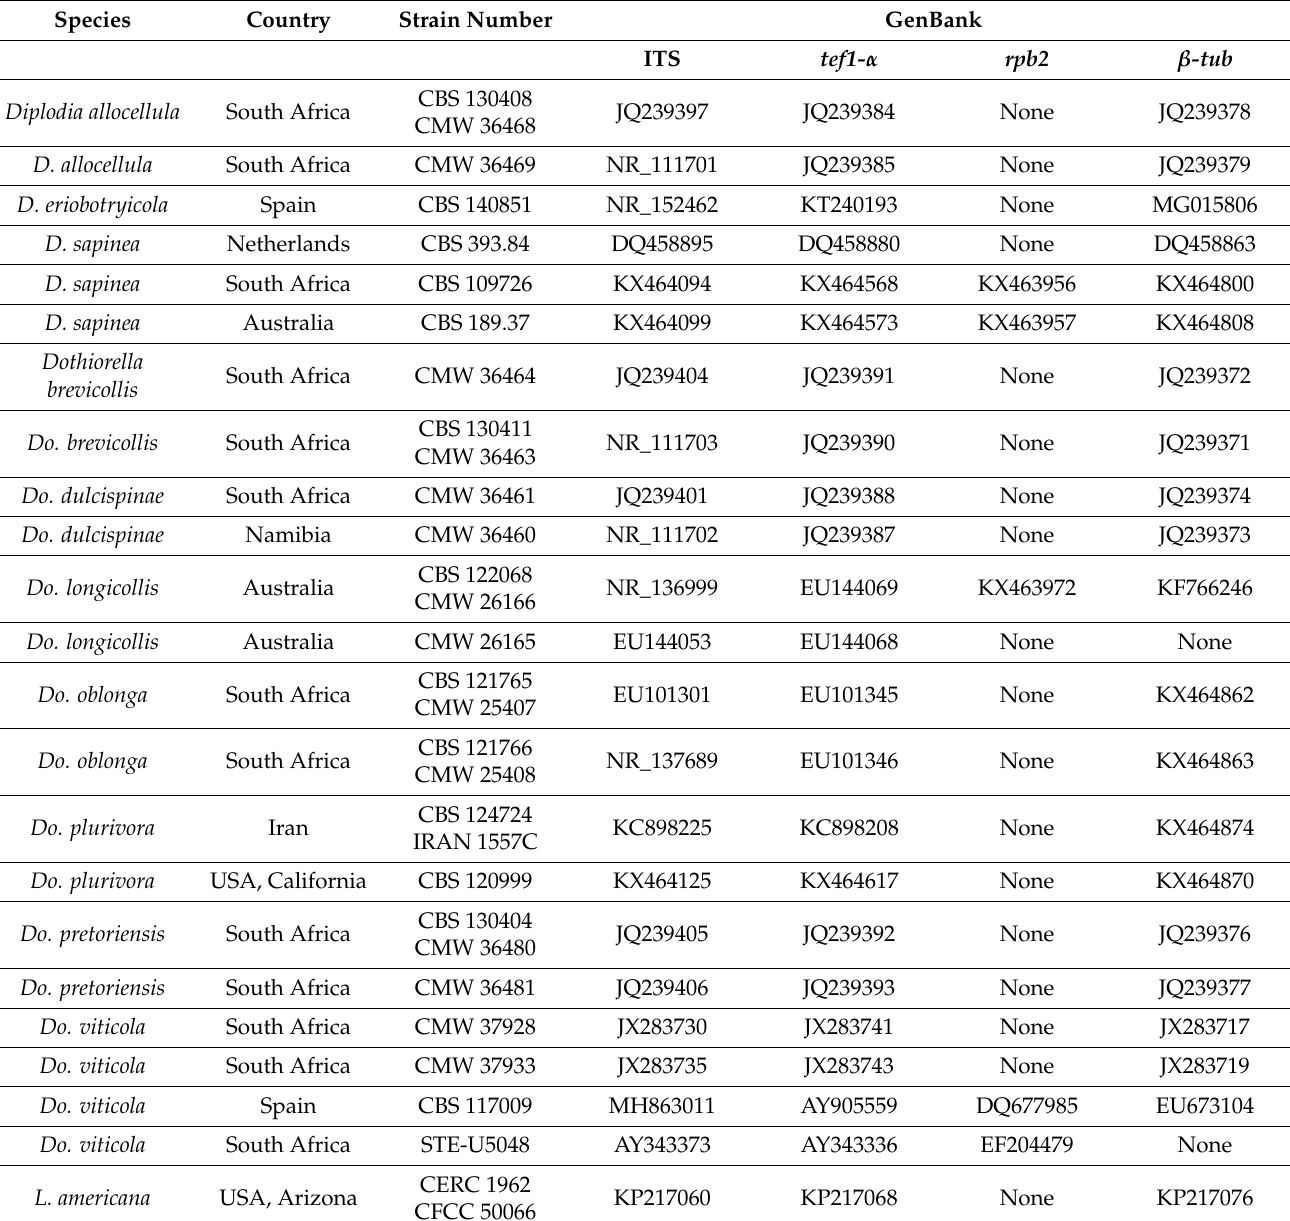
Table 4. Reference sequences obtained from GenBank and used for phylogenetic analyses in this study (species names are as indicated in the GenBank